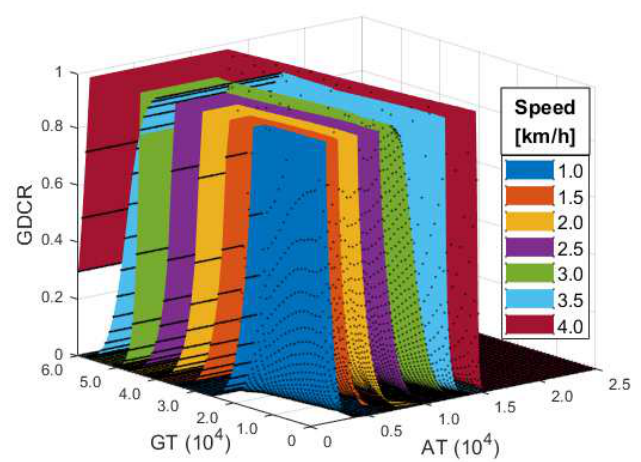
Figure 5. Experimental results of the gait speed effect test.